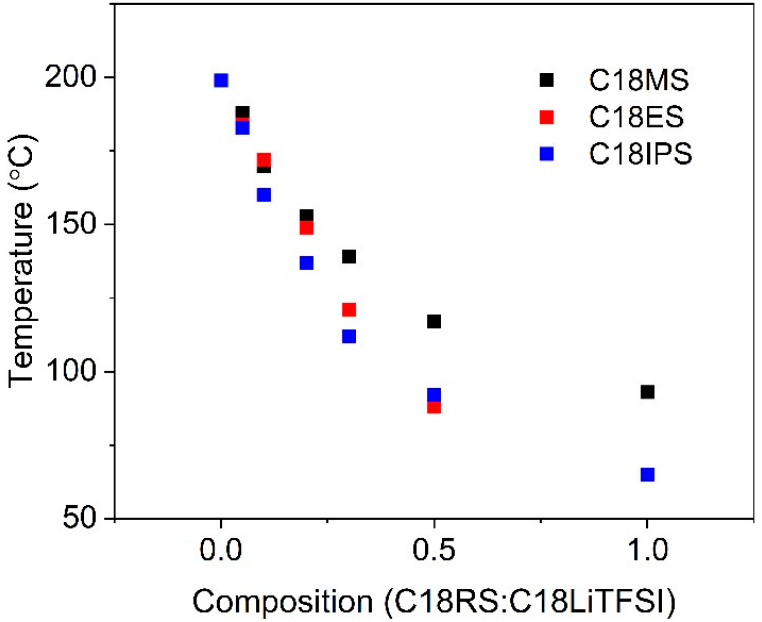
Compared to C18LiTFSI, the addition of the additive molecules has little to no effect on melting point (crystalline to smectic). However, as the C18LiTFSI becomes more dilute due to the addition of the additive molecules, the smectic phase occurs over a smaller temperature range. None of the three additive molecules have liquid crystal phases when pure. This trend based on the ratio of additive holds for all three molecules; however, phase transition temperatures also become lower overall with larger sulfonyl-alkyl groups. The melting points and the smectic to isotropic transitions occur at lower temperatures, with the trend more pronounced at higher ratios (Figure 3). Interestingly, C18ES blends most resemble C18MS blends at low concentrations and C18IPS blends at higher ratios before total loss of the smectic phase.